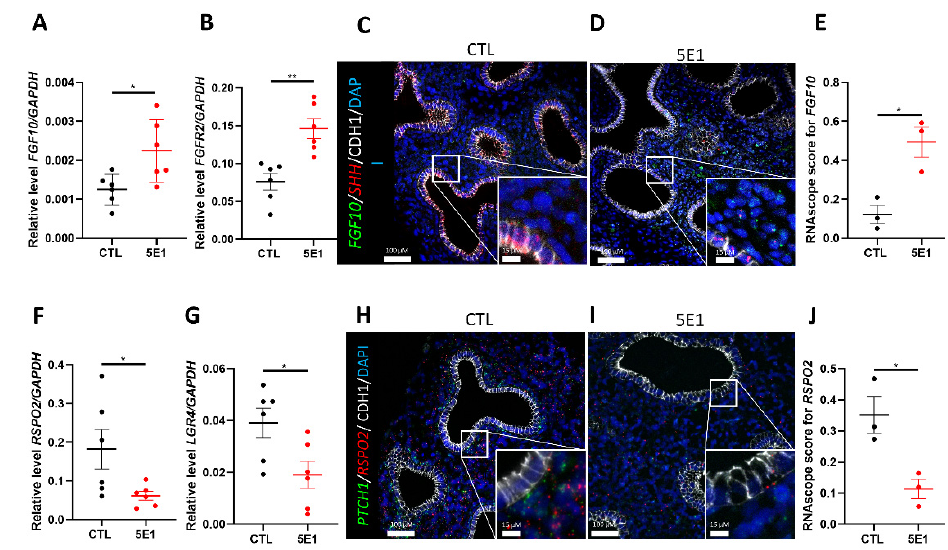
Figure 5. Inhibiting Hedgehog signaling disrupted FGF and WNT pathways. RT-qPCR for FGF10 ( A ) and FGFR2 ( B ) in 5E1-treated explants compared to control (results show mean ± SEM, n = 6 for each group). In situ hybridization for FGF10 (green), SHH (red), and CDH1 (IF-white) performed on control ( C ) and 5E1-treated ( D ) explants. FISH dots quantification ( E ) revealed more FGF10 in 5E1 compared to control (results show mean ± SEM, n = 3 for each group). RT-qPCR for RSPO2 ( F ) and its receptor LGR4 ( G ) on explants treated with 5E1 compared to control (results show mean ± SEM, n = 6 for each group). In situ hybridization for PTCH1 (green), RSPO2 (red), and CDH1 (IF-white) performed on control ( H ) and 5E1-treated ( I ) explants. ( J ) FISH dots quantification for RSPO2 confirmed RT-qPCR results (results show mean ± SEM; n = 3 in each group). * p < 0.05; ** p < 0.01.